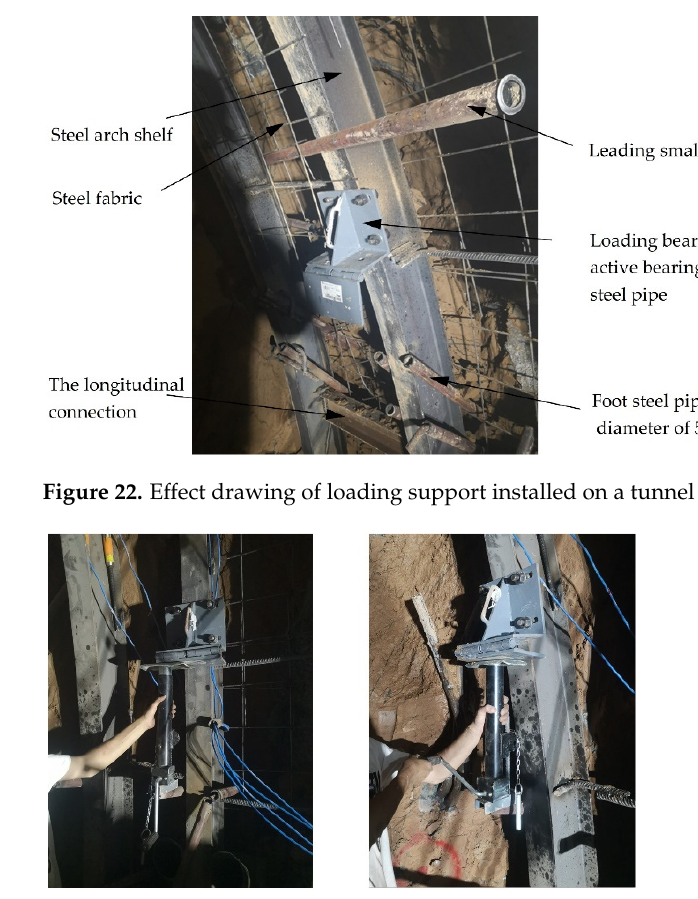
Figure 21. Construction site of tunnel upper bench.